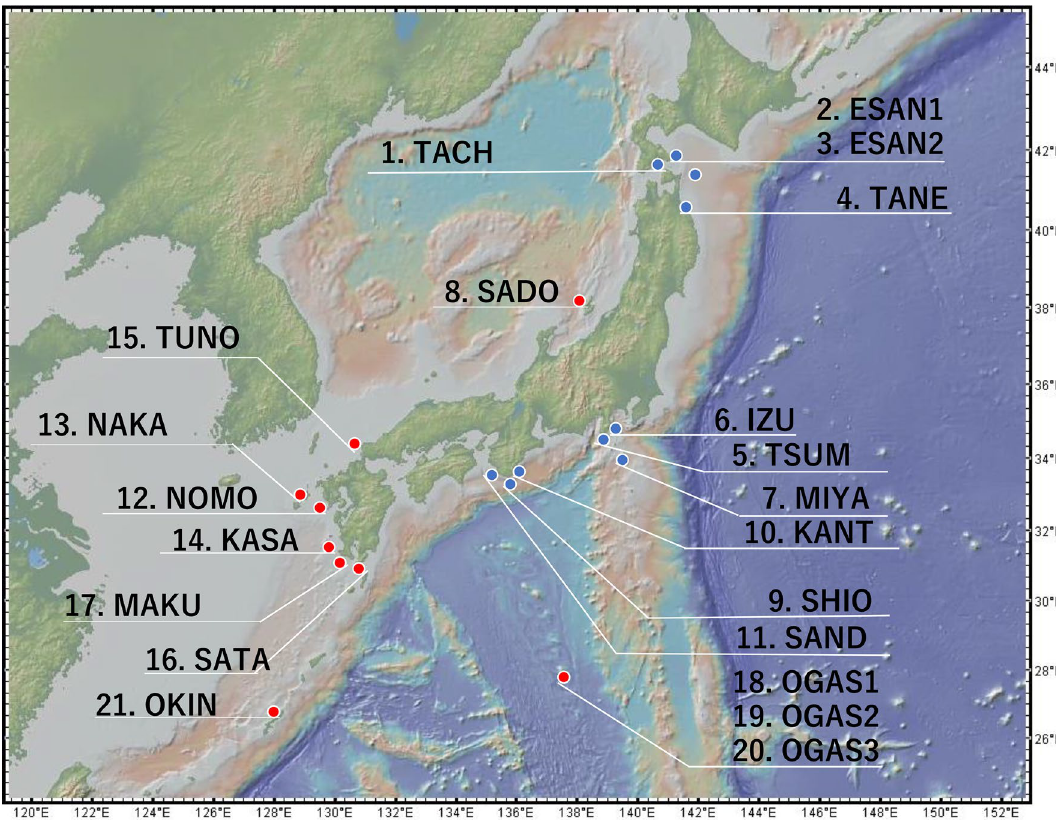
Figure 1. Sampling points of C. falcatum subsp. australe and littorale populations. The red dot shows the location of C. falcatum subsp. australe population and the blue dot shows C. falcatum subsp. littorale population. Population #8 (SADO) was originally considered as subsp. littorale based on the distribution information of the two subspecies in Japan 8 , but subsequent analyses suggested that this population belongs to subsp. Austral . The map was produced by GeoMapApp (http:// www. geoma papp.